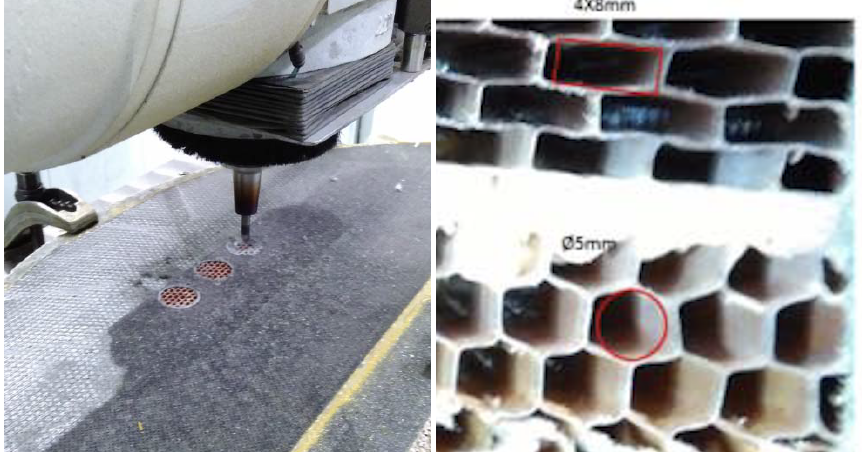
Figure 4. LEFT : Conventional milling operation to remove the CFRP skin of a sandwich panel made with the same cutting tool mounted in the designed end-effector. RIGHT : Detail of the honeycomb panel made of NOMEX, which combines two cell shapes and sizes under the skin.